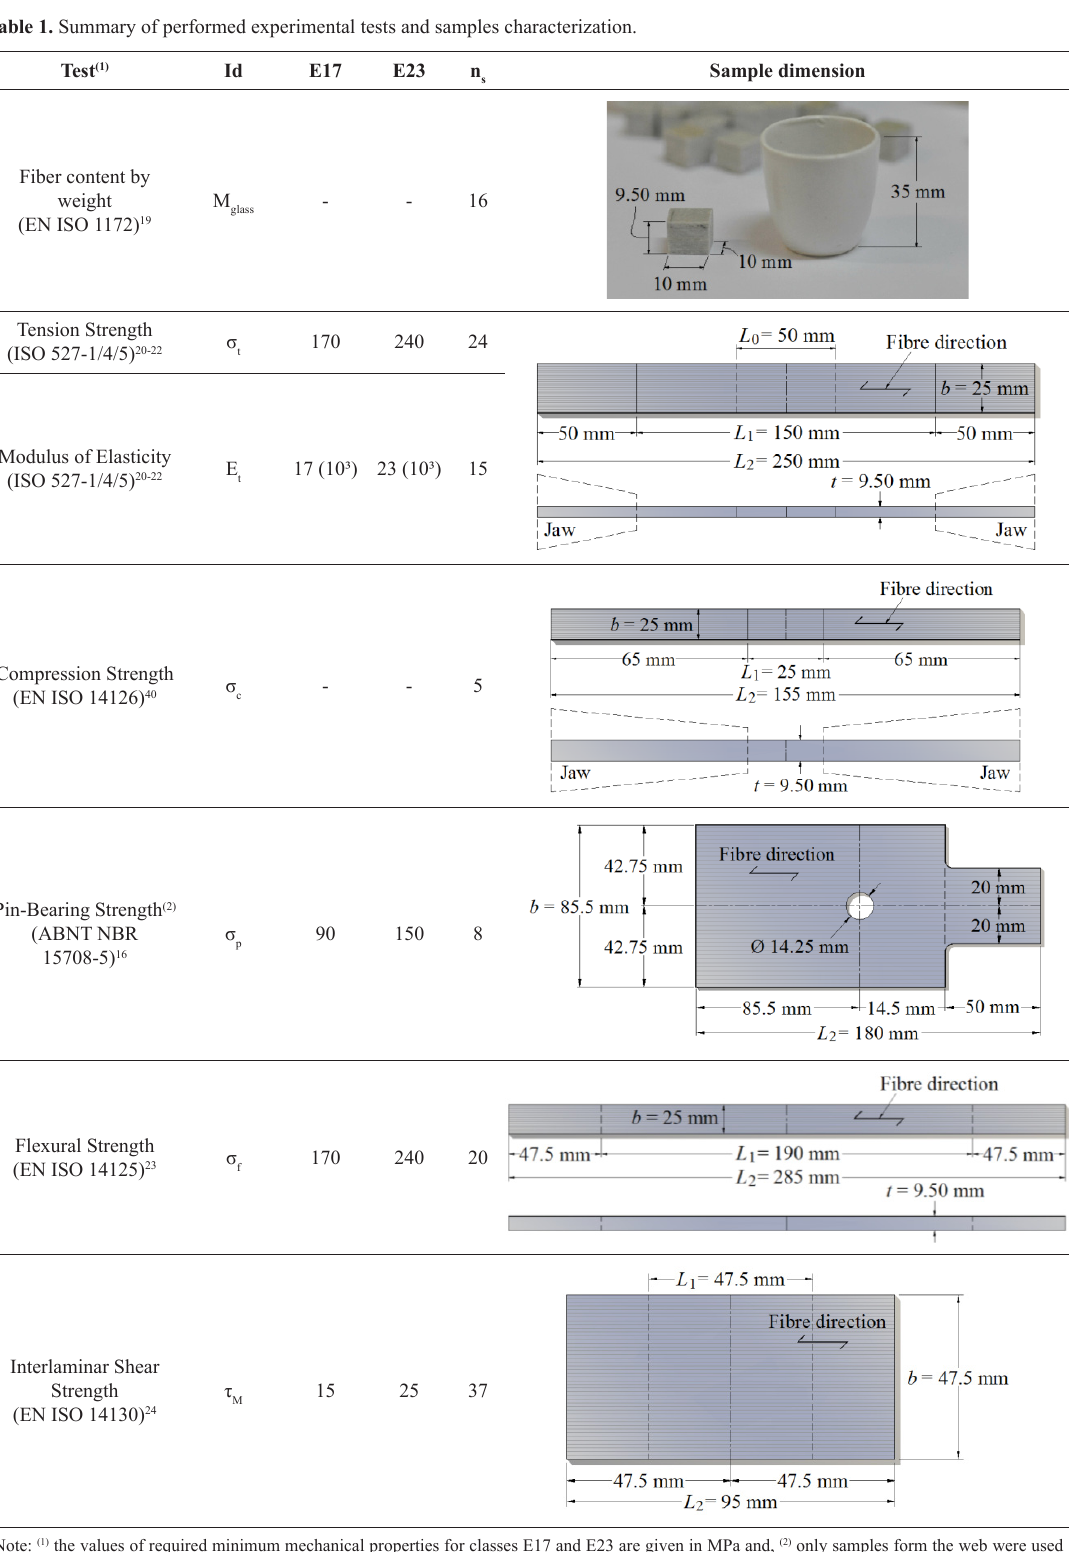
Table 1. Summary of performed experimental tests and samples characterization.